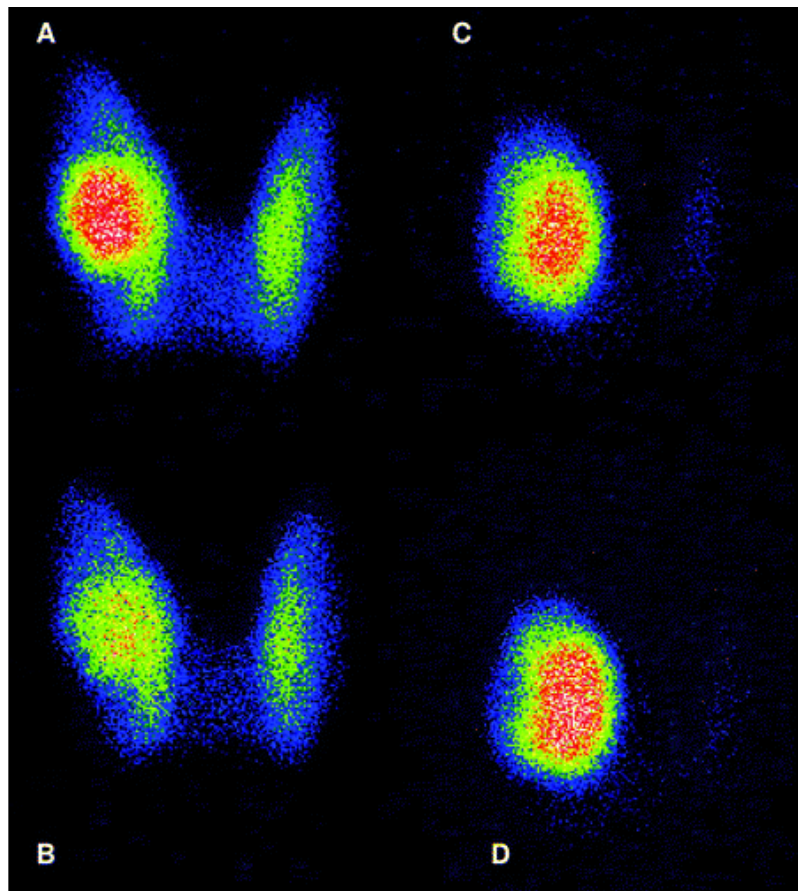
Figure 2. Iodide perchlorate discharge test in two patients with an autonomously functioning thyroid nodule. Iodide perchlorate test was used to evaluate organification defect in patients with an autonomously functioning thyroid nodule (AFTN). A time 0, 26MBq 123 I was administered orally with 500 µg stable iodide. Three hours later, a first scintigraphy was acquired, followed immediately by the oral administration of perchlorate. One hour later, a second scintigraphy was obtained. After correction for radioisotope decay, discharge can be evaluated by comparing the counts before and after perchlorate. Thyroid scan in a patient with a positive discharge test before ( A ) and after ( B ) perchlorate. Thyroid scan in a patient with a negative perchlorate test before ( C ) and after ( D )